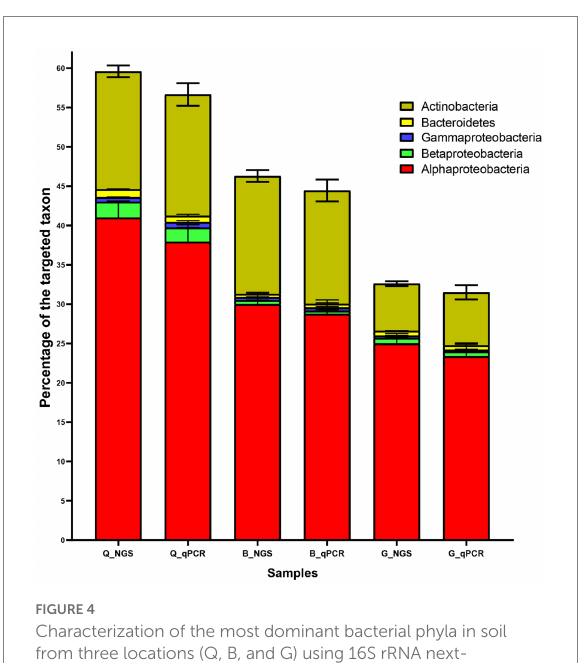
Alphaproteobacteria correlated with HCO3 − , while SO 42 − was a determinant nutrient for Proteobacteria. Actinobacteria positively correlated with available potassium and Mg 2+ . On the other hand, Cu and Fe concentrations negatively influenced Alphaproteobacteria, Gammaproteobacteria, and Actinobacteria. Also, Bacteroidetes negatively correlated with Mn concentration. Finally, the Pearson’s correlation was performed between the percentage of the bacterial taxa (obtained from qPCR) and the measured wheat agro-morphological traits (Figure 8B). The results showed a significant positive correlation between PL, FLA, and WTK and both Alphaproteobacteria, and Bacteroidetes. NKS and TY positively correlated with